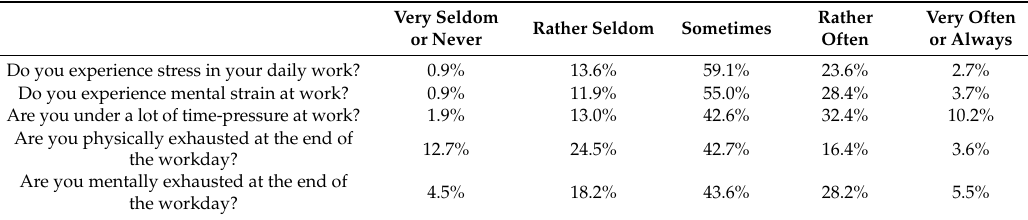
Table 2. Descriptive statistics for stress at work, mental strain, time pressure, and physical and mental